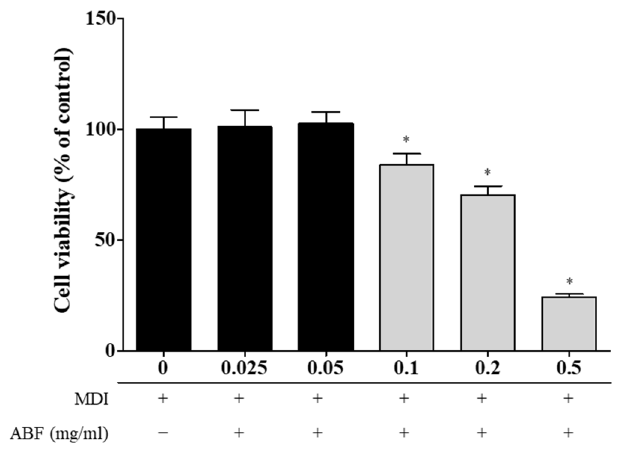
Figure 4. Effects of Aronia bioactive fraction (ABF ® ) on 3T3-L1 adipocyte cell viability. Cell